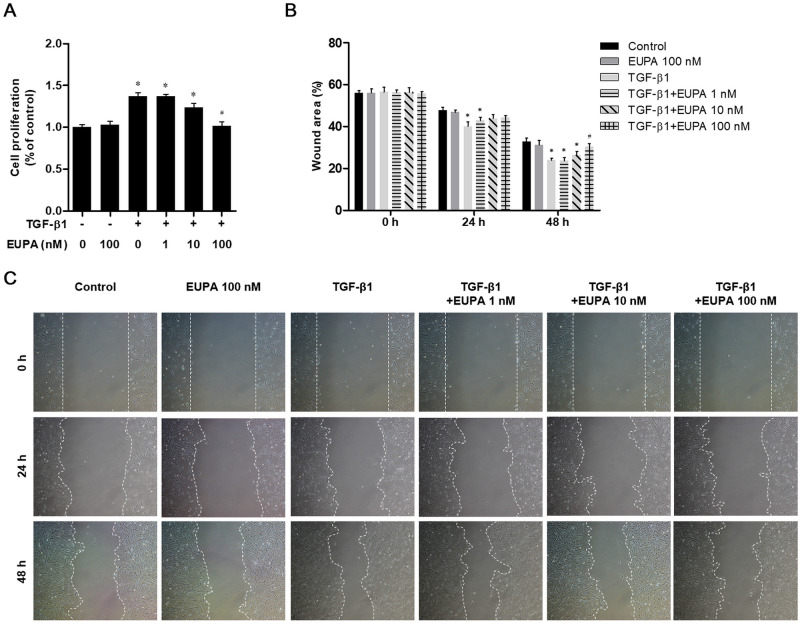
Effect of eupatilin on hVFFs proliferation and motility induced by TGF-β1.(A) hVFFs were treated for 48 h with TGF-β1 (10 ng/ml) plus 1, 10, or 100 nM eupatilin, or with 100 nM eupatilin alone. Cell proliferation was determined in an MTT assay. (B) Cell migration was evaluated by the wound healing assay. (C) Uncovered areas in the wound healing assays were quantified as the percentage of the original wound area. Data are representative of three independent experiments performed in triplicate and are expressed as the mean ± SEM. * p < 0.05 vs. TGF-β1 untreated control (TGF-β1 = 0 ng/ml).# p < 0.05 vs. eupatilin untreated control (eupatilin = 0 nM).